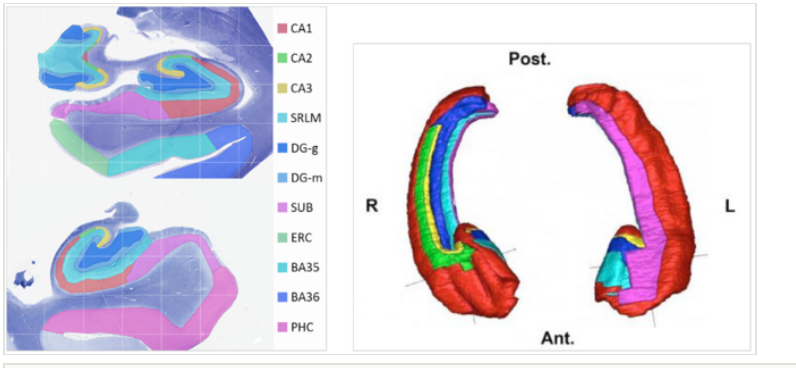
Figure 2. Example hippocampal sub fi eld labels. Left: Example of hippocampal sub fi eld labeling. Right: The fi rst work demonstrating hippocampal sub fi eld labels in MRI space that are derived from ground-truth histological imaging (Adler et al.